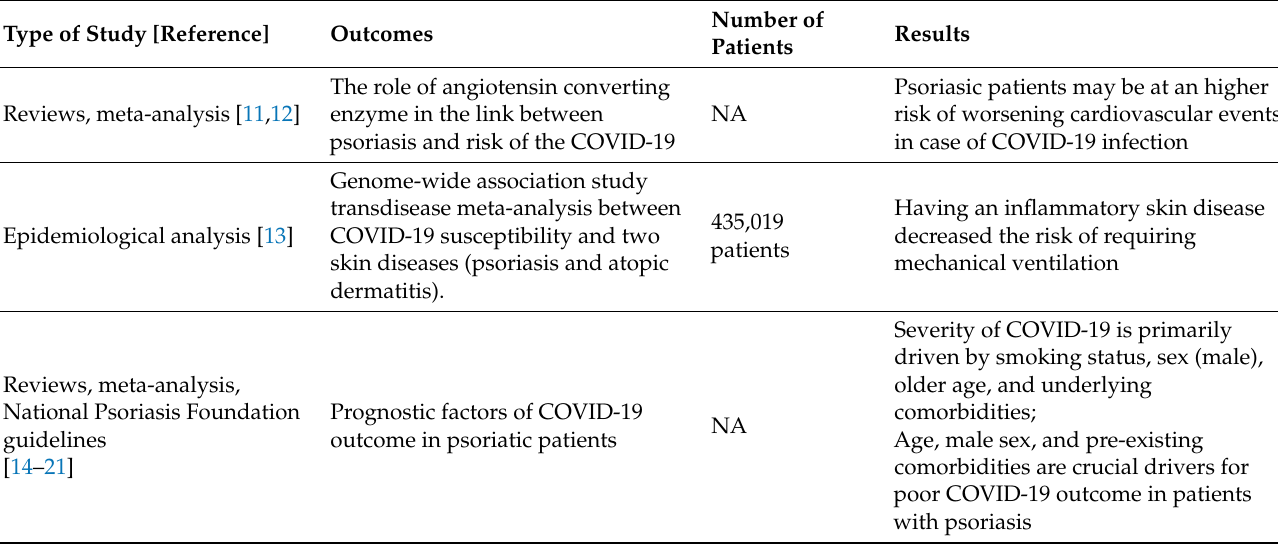
Table 2. Impact of psoriasis on SARS-CoV-2 infection. NA: not